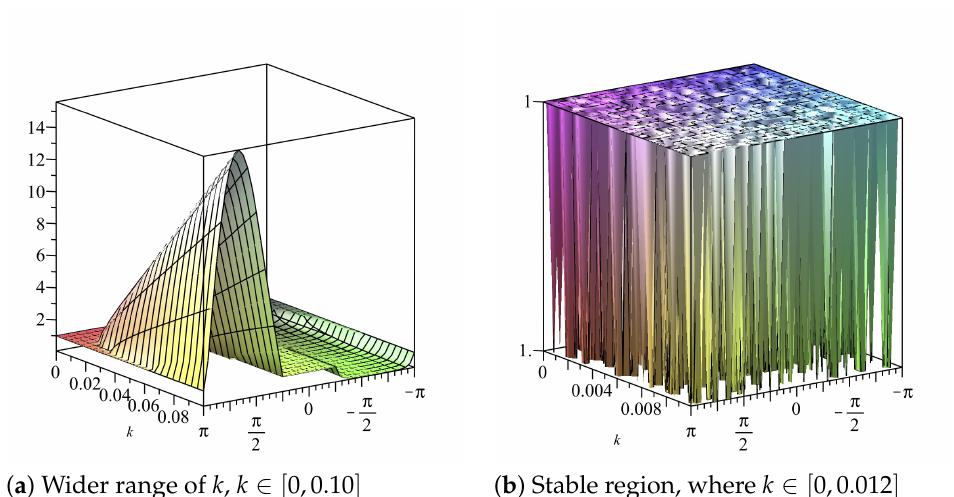
Figure 1. Plot of | ξ 1 | vs. k vs. w ∈ [ − π , π ] of Scheme 1 for Numerical Experiment 1. The spatial step size is h = π